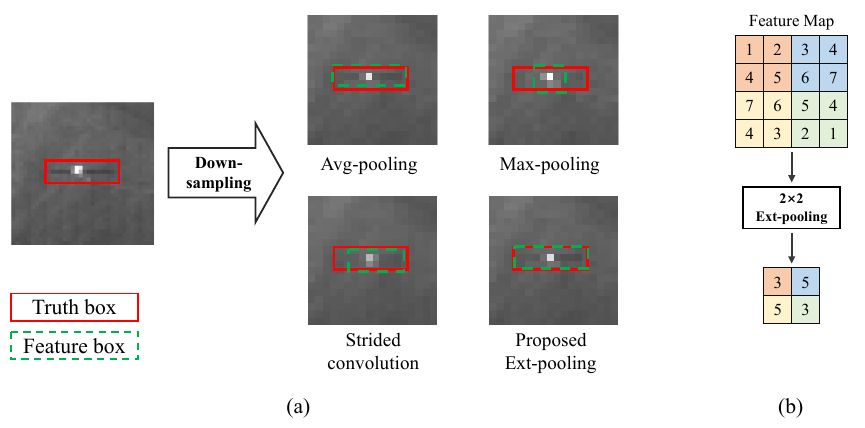
Figure 4. ( a ) shows the comparison of different downsampling methods. ( b ) shows an example of [( max ( 1,2,4,5 ) + min ( 1,2,4,5 )] Ext-pooling, Ext - pooling ( 1,2,4,5 ) = 1 2